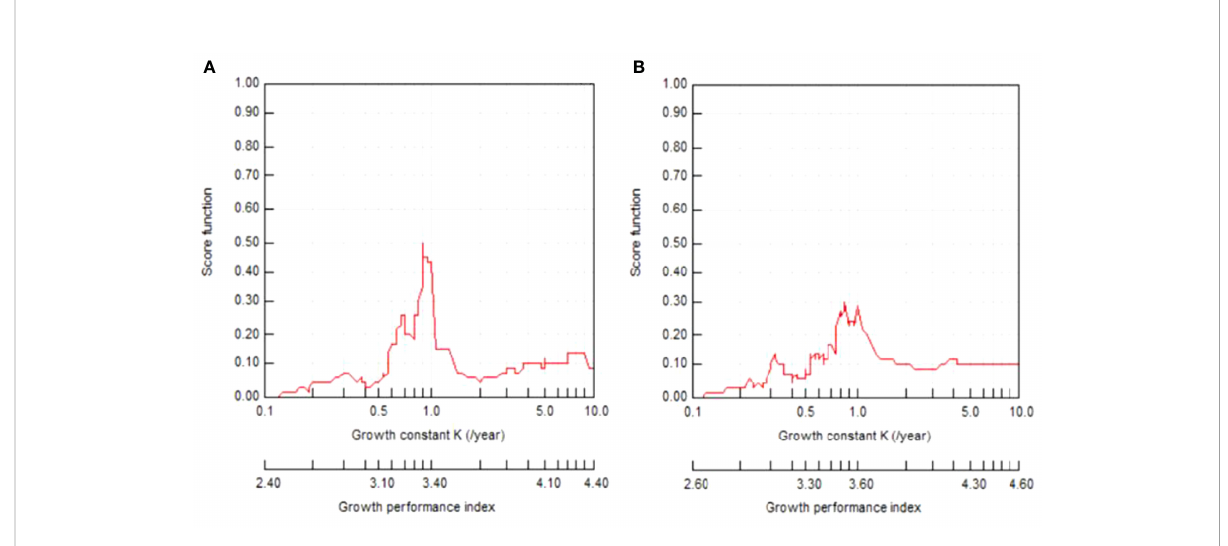
FIGURE 9 ELEFAN I K-scan routine FiSAT II output for (A) male and (B) female P. elegans from the southeast Caspian Sea (2019 –